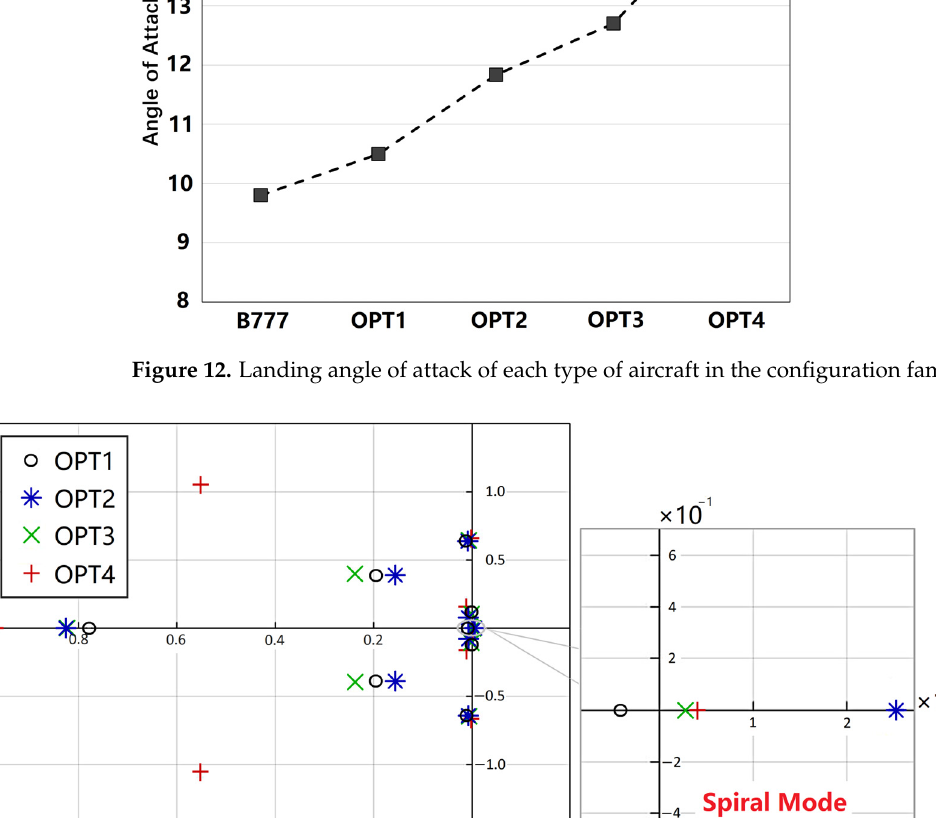
Figure 13. Poles of aircraft dynamics for landing status of four configurations.